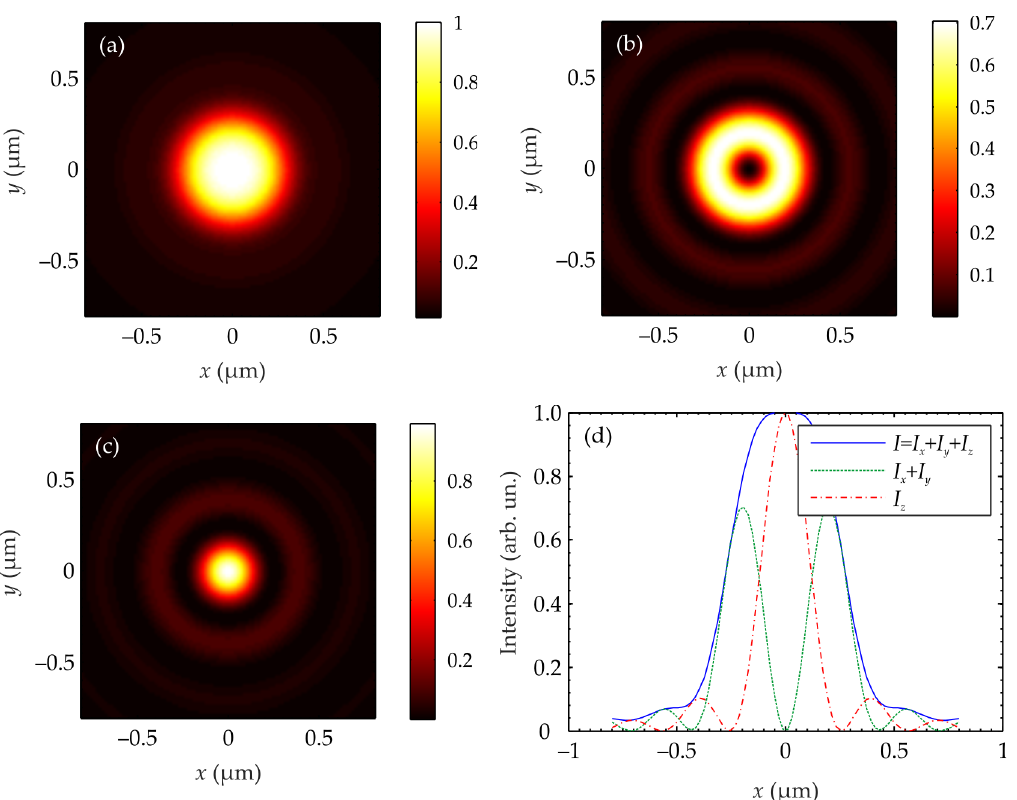
Figure 9. Focal spot diameter at full width at half maximum when focusing an optical vortex ( m = − 1) with circular polarization when focusing with a flat diffractive lens. When the numerical aperture of the lens is approximately equal to NA = 0.93, a flat top is observed at the formed focus (Figure 10), and the focal spot diameter for this case is FWHM = 1.03 λ .